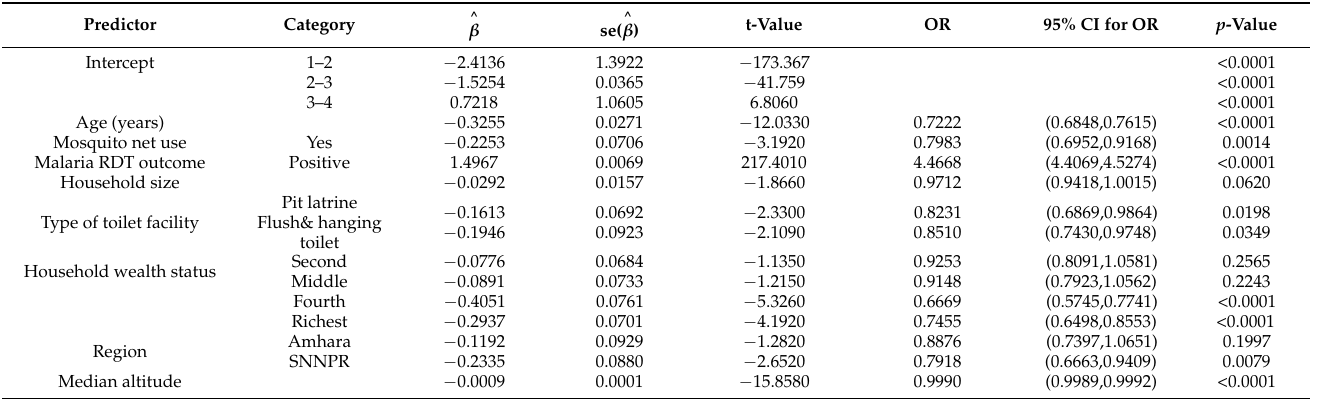
Table 3. Results of final multivariate cumulative logit model for the relationship of anaemia preva- lence to predictor variables without considering survey